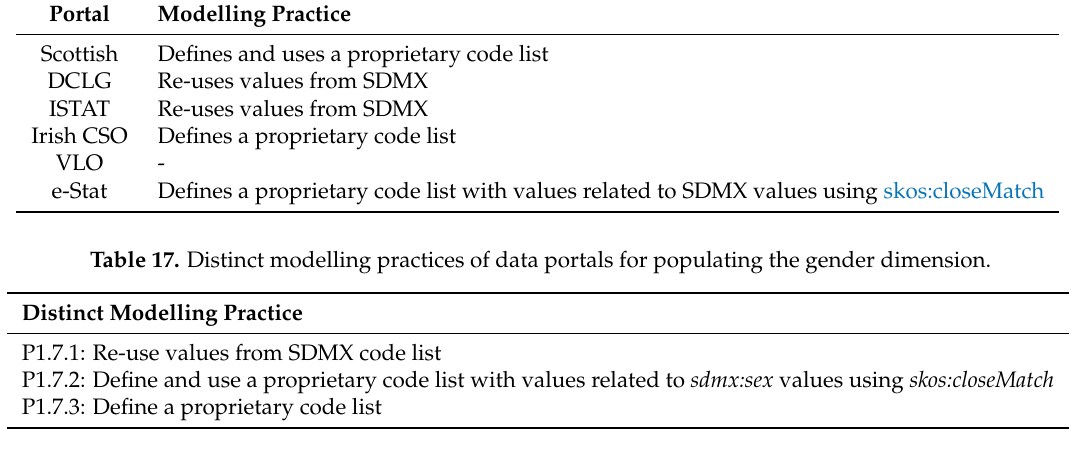
Table 16. Modelling practices of data portals for populating the gender dimension. Portal